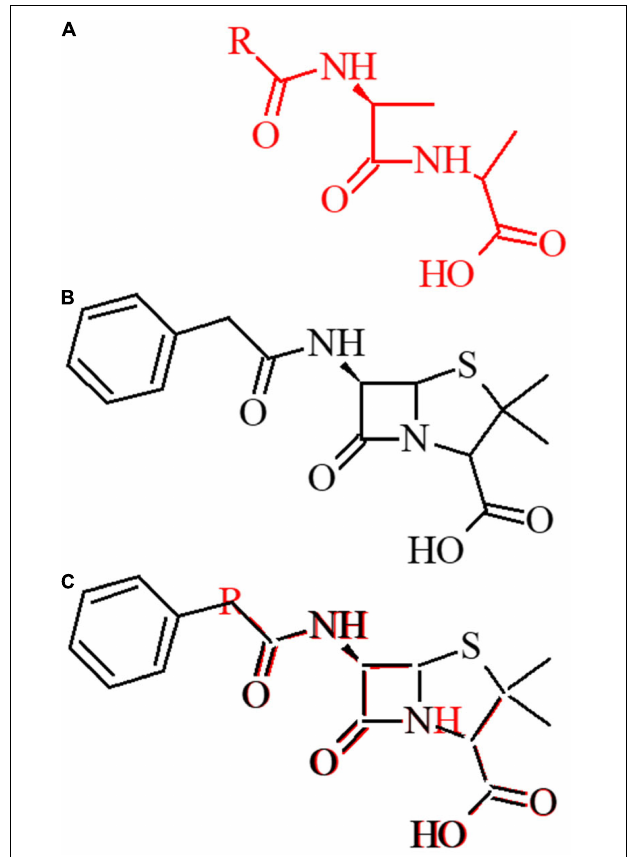
FIGURE 2 | Structural basis of lactam activity. (A) The D -Ala- D -Ala amino acid is depicted in red. (B) The 1st generation penam ampicillin is depicted in black. (C) D -Ala- D -Ala dipeptide overlay with the β -lactam ampicillin antibiotic.